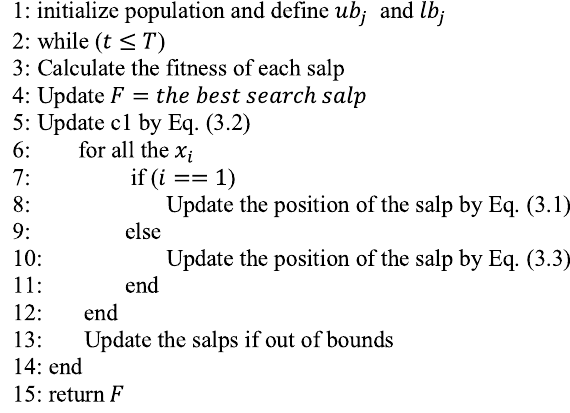
Algorithm 1. 1: initialize population and de fi ne ubj and